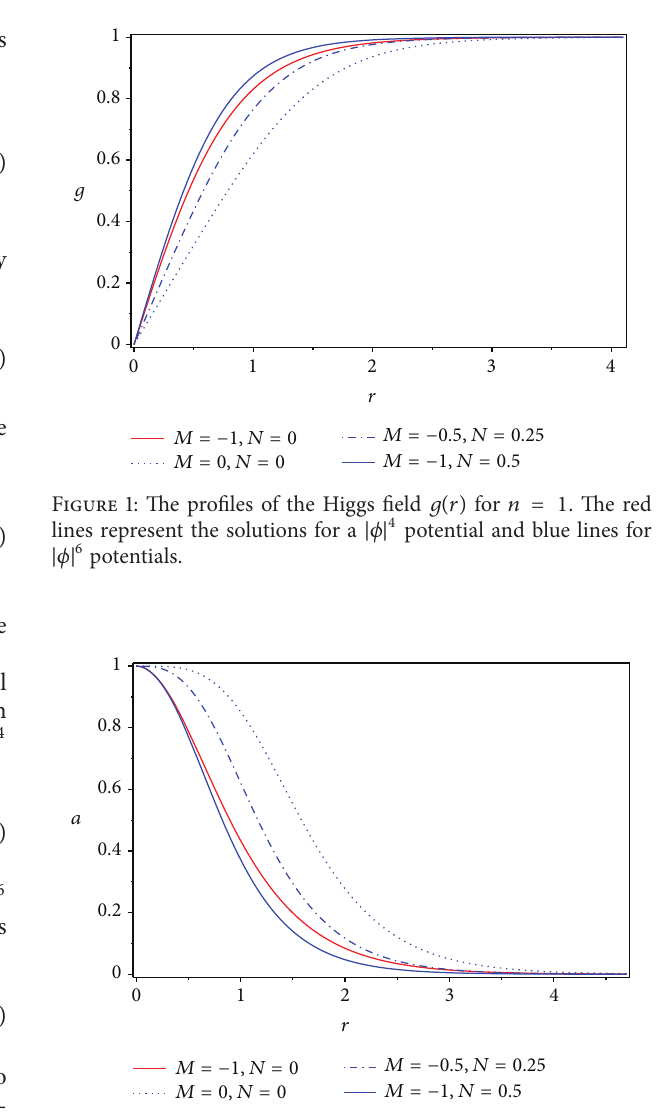
Figure 2: The profiles of the gauge field 𝑎(𝑟) for 𝑛 = 1 . The red lines represent the solutions for a |𝜙| 4 potential and blue lines for |𝜙| 6